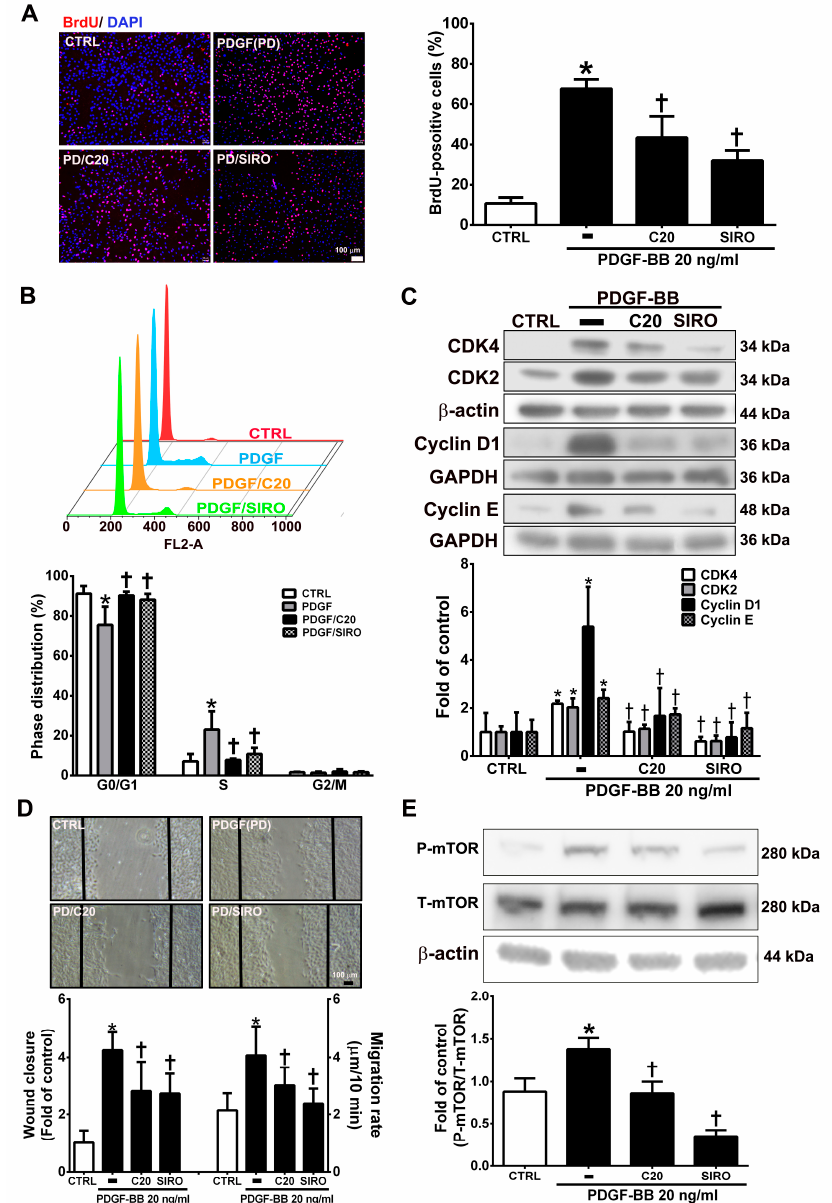
Figure 6. Corylin inhibited proliferation and migration in VSMCs induced by platelet-derived growth factor-BB (PDGF-BB) . VSMCs were pretreated (1 h) with 20 µ M corylin (C20) or 5 nM sirolimus (SIRO; an mammalian target of rapamycin (mTOR) inhibitor) and then treated with 20 ng / mL PDGF-BB (PD) for 24 h. ( A ) BrdU incorporation, and ( B ) Cell cycle analysis by flow cytometry were used to examine VSMC proliferation. Nuclei were labeled with DAPI (blue). ( C ) Western blot analysis for CDK4, CDK2, Cyclin D1, or Cyclin E and quantification of CDK4, CDK2, Cyclin D1 or Cyclin E to β -actin or GAPDH in VSMCs. ( D ) Wound healing assays was used to measure the VSMCs wound closure and migration rates. Confluent VSMCs were wounded by scratch injury (black lines). ( E ) Western blot analysis for P-mTOR and quantification of P-mTOR to T-mTOR in VSMCs. β -actin was used as an internal control for sample loading. The data are the mean ± SD. * p < 0.05 versus the untreated group (CTRL). † p < 0.05 versus the PDGF-BB-treated group. The scale bars = 100 µ